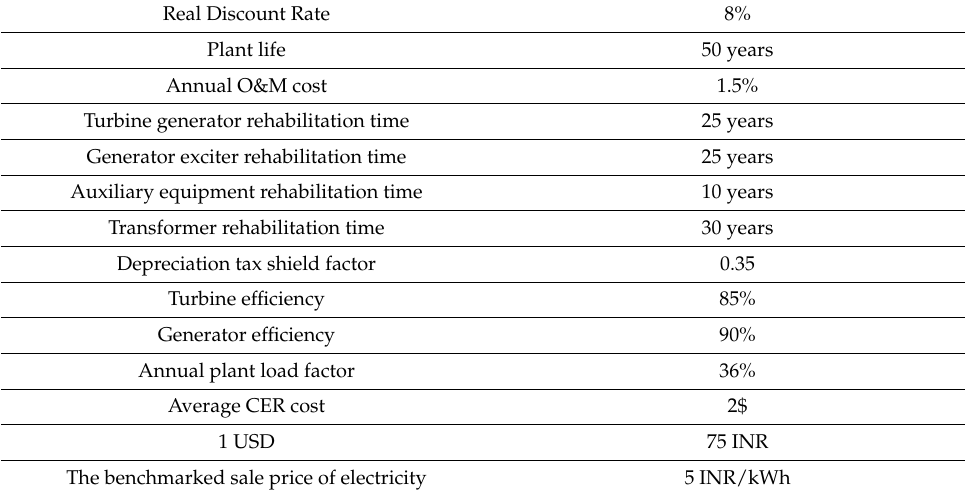
Table 4. Economic assumptions for LCC calculations.